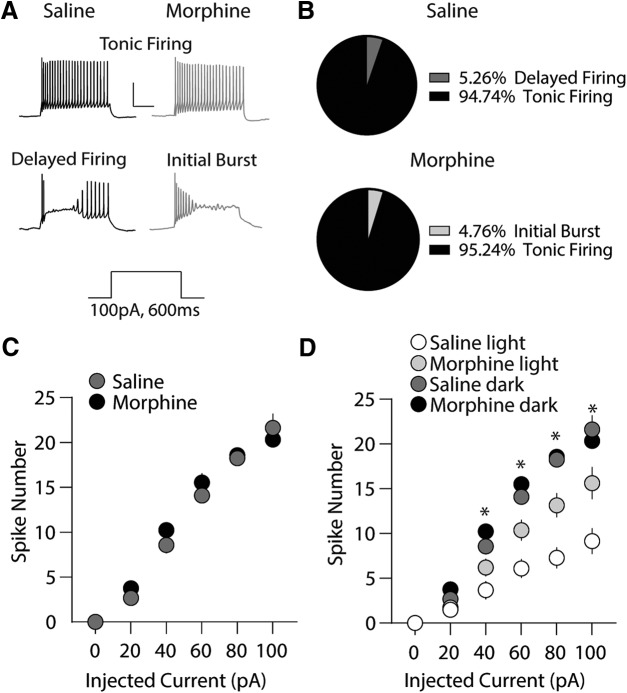
Repeated morphine exposure during the dark cycle has no effect on intrinsic membrane excitability of PVT neurons recorded in the dark cycle. A, Example traces demonstrating the two firing phenotypes observed in response to a depolarizing current injection (100 pA for 600 ms); tonic and delayed firing (saline, left; morphine, right). PVT neurons from morphine-treated animals only expressed tonic firing responses to current injected. Scale bars: 40 mV, 200 ms. B, Quantification of firing phenotypes in PVT neurons following repeated saline or morphine treatment. C, Summary showing that 24 h following repeated morphine injections during the dark cycle, the number of action potentials fired in PVT neurons is unaltered (F(5,190) = 1.41, p = 0.221; two-way repeated measures ANOVA with Bonferroni post hoc test; saline: n = 19/5; morphine: 21/6). D, Summary showing intrinsic membrane excitability of PVT neurons recorded during the light or dark cycle in saline-treated or morphine-treated animals (Bonferroni post hoc test; 40 pA: saline light versus saline dark**, morphine light vs morphine dark**, saline light vs morphine dark*; 60 pA: saline light versus saline dark**, morphine light vs morphine dark**, saline light vs morphine dark**, morphine light vs saline dark*, saline light vs morphine light**; 80 pA: saline light vs saline dark**, morphine light vs morphine dark**, saline light vs morphine dark**, morphine light vs saline dark**, saline light vs morphine light**; 100 pA: saline light vs saline dark**, morphine light vs morphine dark**, saline light vs morphine dark**, morphine light vs saline dark**, saline light vs morphine light**; *p < 0.05, **p < 0.01; light = light cycle; dark = dark cycle.